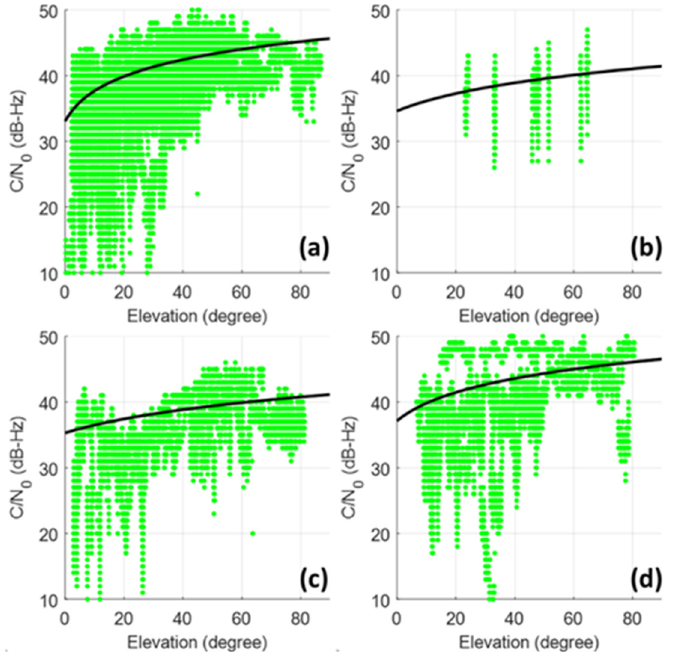
Figure 3. The open-sky elevation- C / N 0 regression model for satellites from different systems or orbits, including: ( a ) GPS satellites; ( b ) Beidou GEO satellites; ( c ) Beidou IGSO satellites; ( d ) Beidou MEO satellites. The green marker in each subfigure denotes the collected data from different satellites used for curve fitting. The black curve denotes the 1st order polynomial fitting model obtained from the C / N 0 data with the unit of Hz and visualized with the unit of dB-Hz. The green dots denote the C / N 0 data collected from a commercial grade receiver (Ublox EVK M8T) with a patch antenna in the open-sky environment.